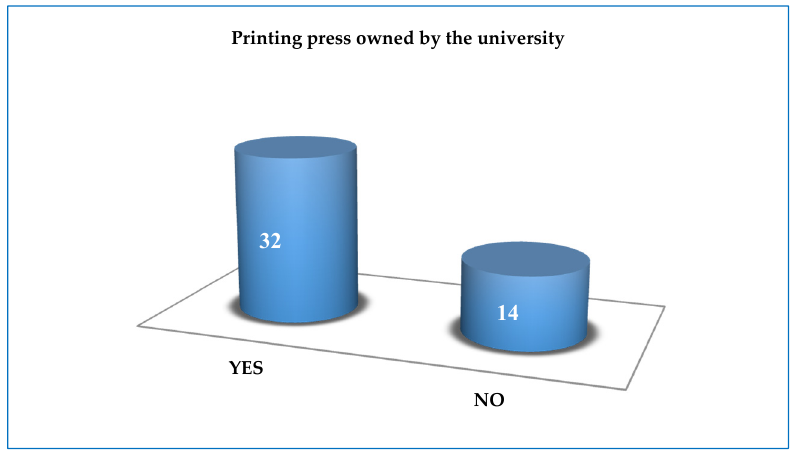
Figure 3. Access to in-house printing facilities.